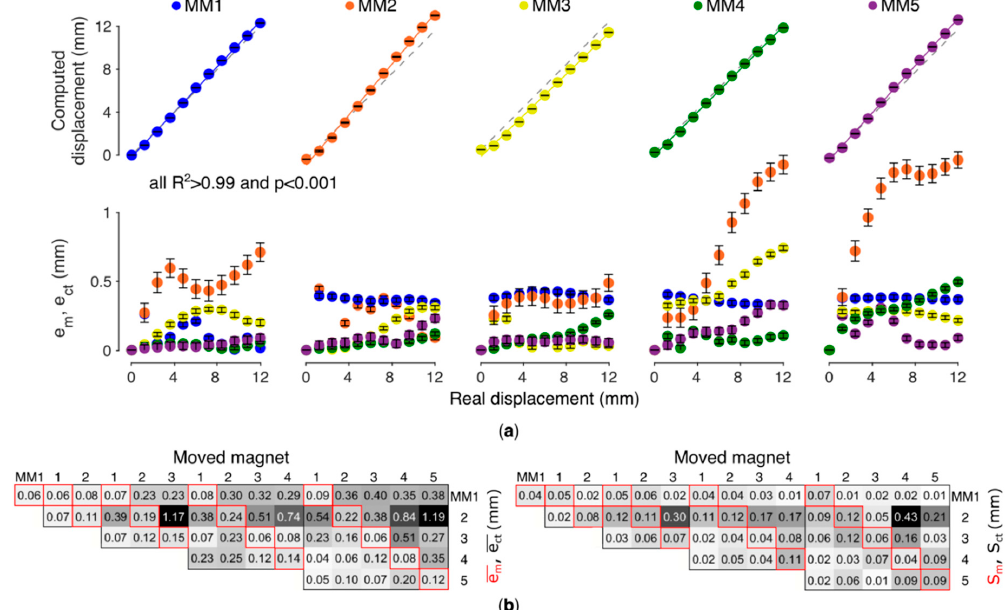
Figure 5. Performance of the localizer under anatomical conditions (forearm mockup). ( a ) Accuracy ( e m and e ct ) in retrieving the (position) displacement of the magnets for a representative configuration (five MMs, 32 sensors). Each MM was moved along a trajectory of 12 mm, while the remaining MMs were kept at their initial / rest position. Error bars indicate S m or S ct . ( b ) Metrics ( e m , e ct , S m and S ct ) averaged across the trajectory check-points for each tested configuration of magnets (from one to five). The figures in the diagonals (in red) represent the single magnet accuracy ( e m —left panel) and precision ( S m —right panel); those in non-diagonal positions represent the cross-talk contributions ( e ct —left; S ct —right).